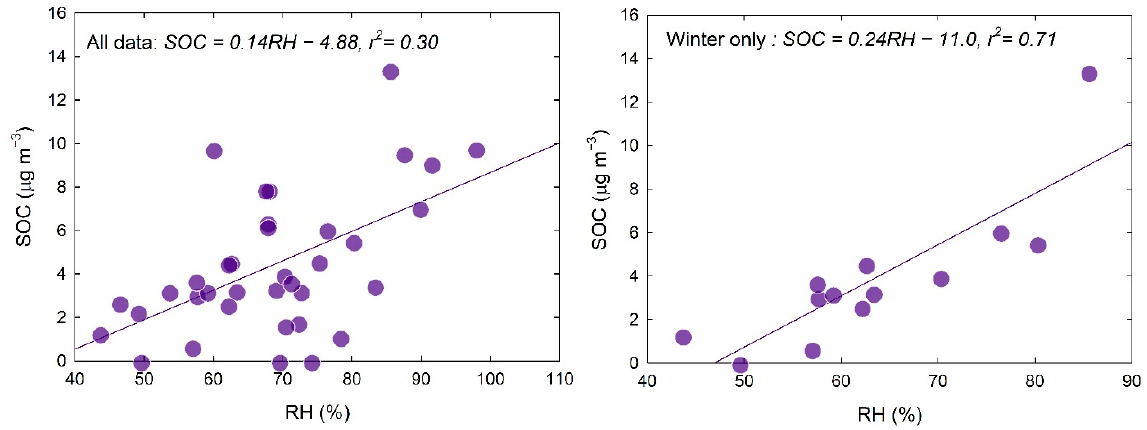
Figure 7. The effect of RH on SOC concentrations for all HC samples ( left ) and only winter HC samples ( right ).